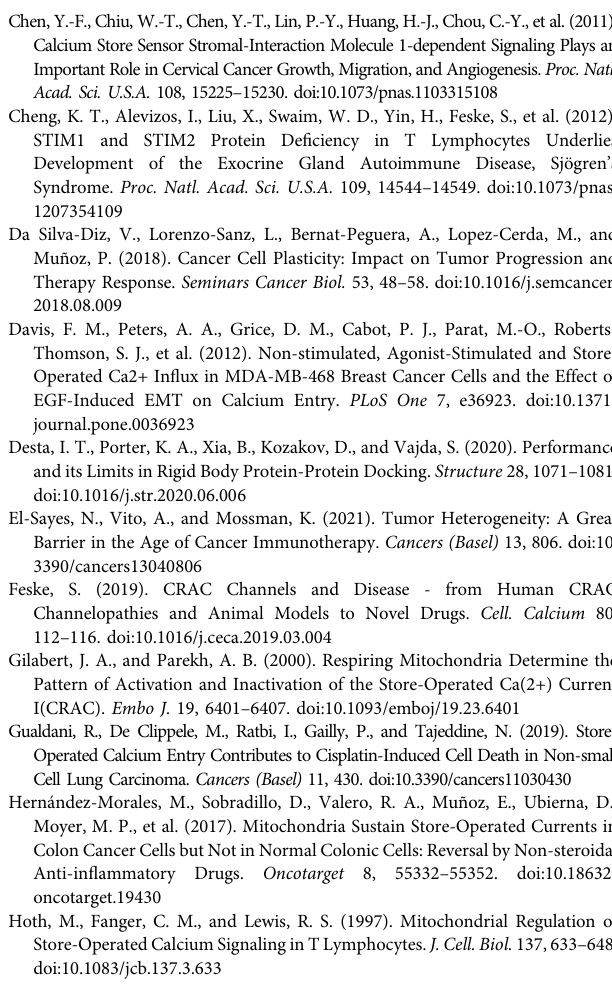
Supplementary Figure 1 | Graphical